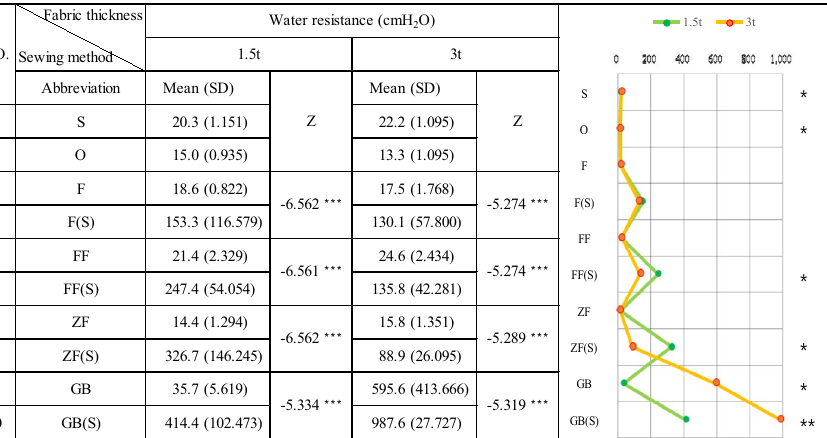
Table 5 Test results of the Wilcoxon signed rank t-test for water